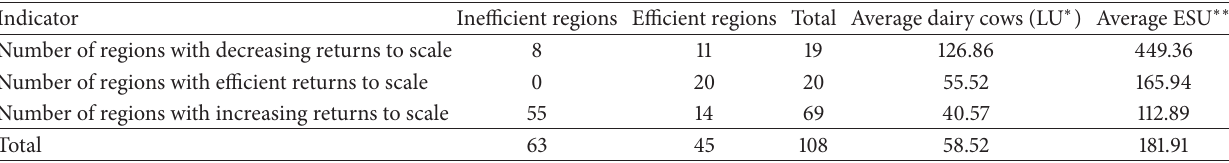
Table 3: Distribution of the returns to